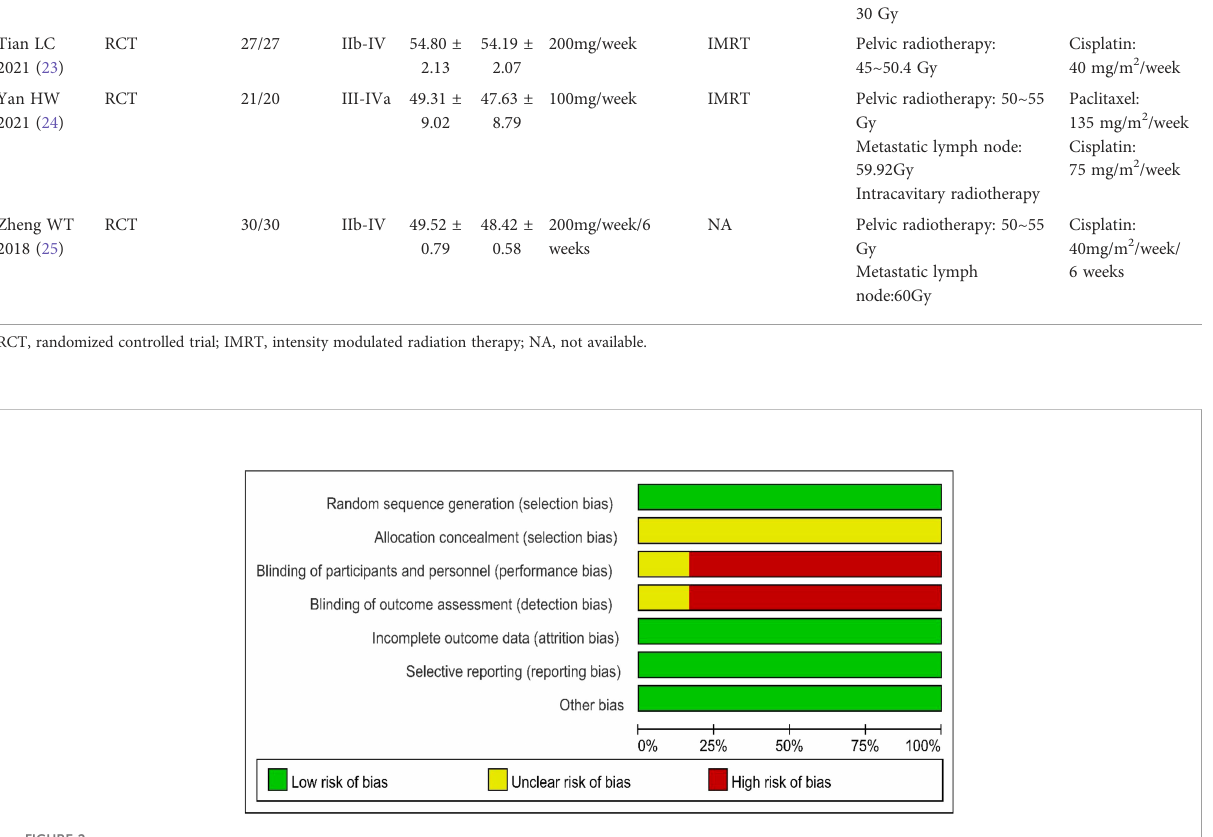
FIGURE 2 Risk of bias assessment.